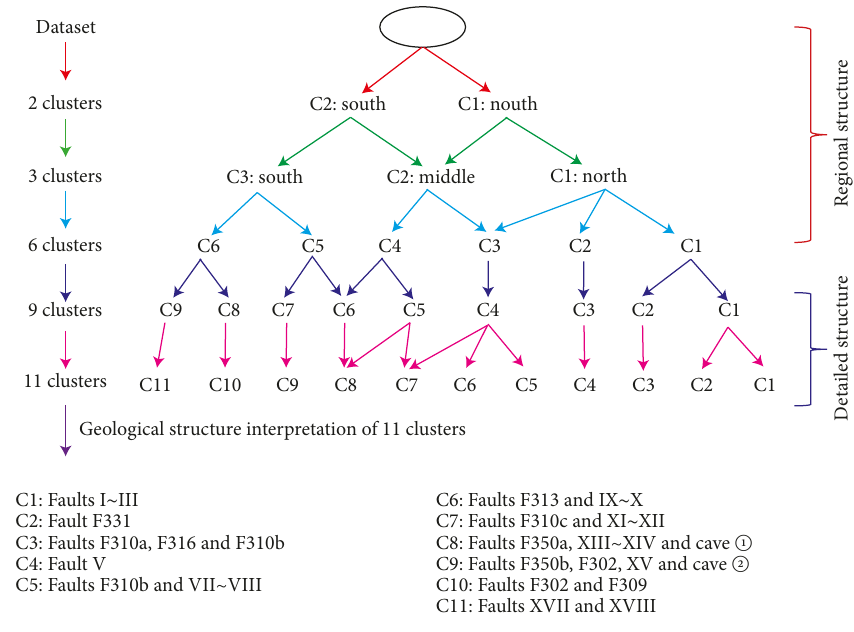
Figure 5: 𝐾 -Means clustering process diagram and geological structure interpretation of 11 clusters for Figure 4.